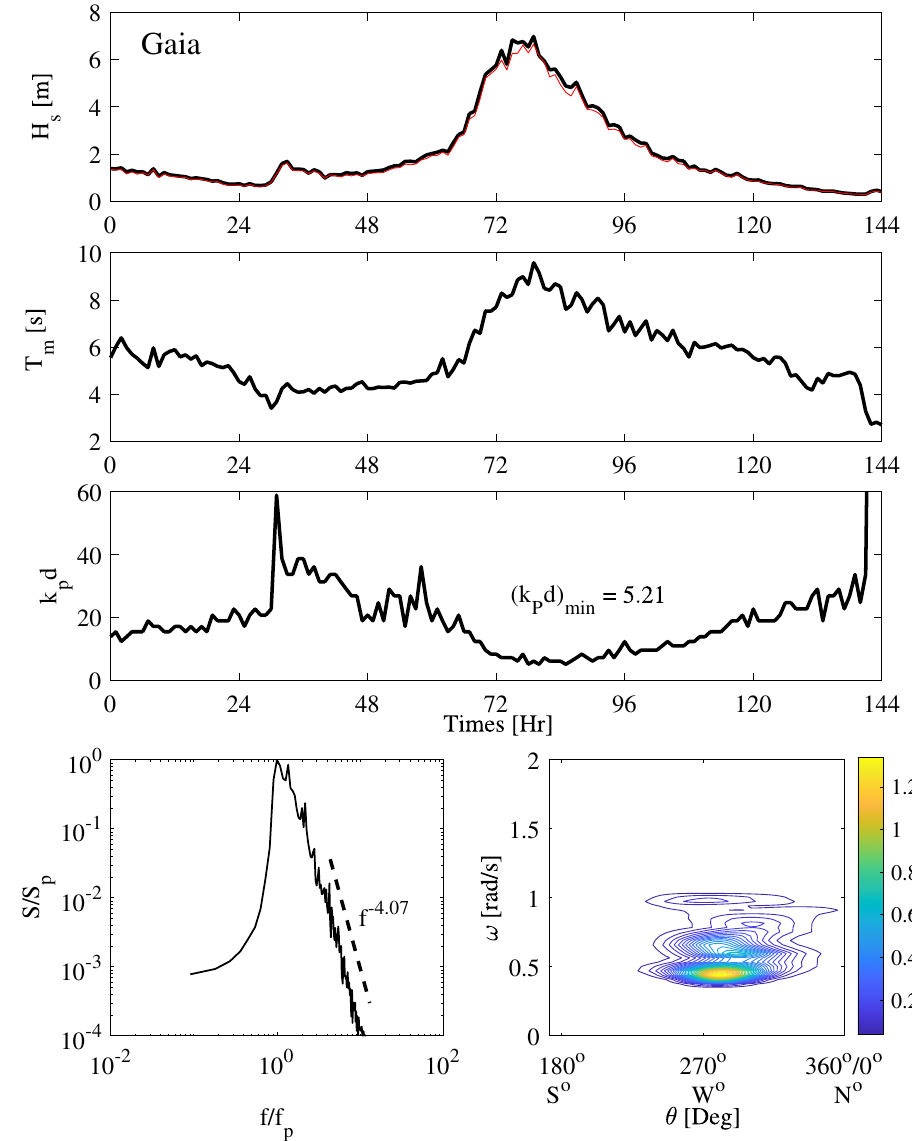
Figure 2. Metocean parameters history during Gaia storm: (top panels) hourly variation of the significant 4 σ (black) and H 1 / 3 (red), mean zero-up-crossing wave period T 0 , and depth wave height estimated as H s = factor k p d ; (bottom-left) normalized frequency spectrum S ( f )/ S p and (bottom-right) the directional spectrum m 2 / rad/s/deg Hz m 2 / Hz S (ω , θ) ( ) at the storm peak. Here, S p ( ) and f p ( ) are the spectral amplitude and [ ] [ ] [ ] frequency at the storm